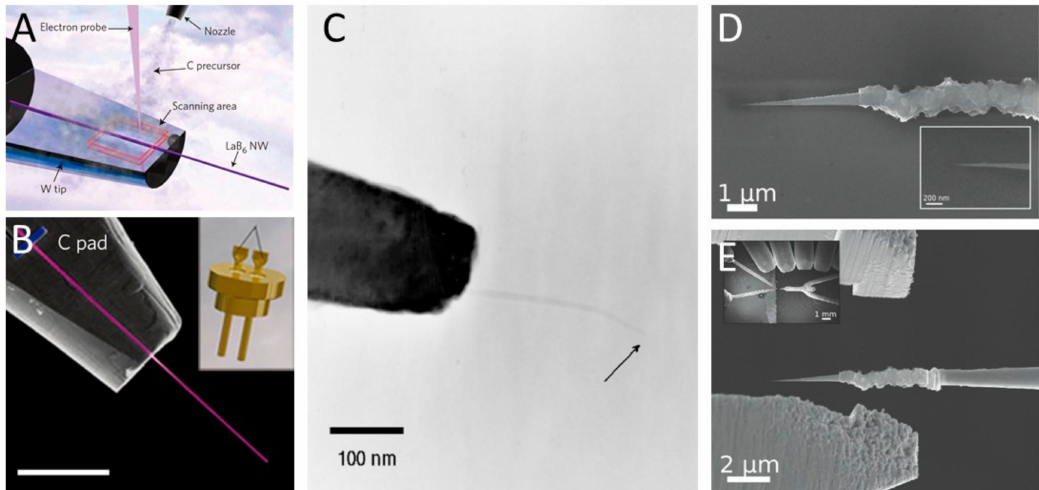
Figure 2. Well-developed nanowire, nanotube, and nanocone point-cathode cold field emitters. ( A ) Illustration showing the electron beam deposition process to fix a LaB 6 nanowire onto a W needle; ( B ) SEM image showing the finished LaB 6 NW emitter and the complete emitter assembly used for field-emission SEM, scale bar, 10 µ m. Reproduced with permission from [16], Copyright Springer Nature, 2015; ( C ) Transmission electron microscopy (TEM) image of a very thin and short nanotube sample. Reproduced with permission from [10], Copyright Elsevier, 2003; ( D ) View of part of the starting carbon cone nanotip (CCnT) object; ( E ) Resulting new tip after welding the carbon